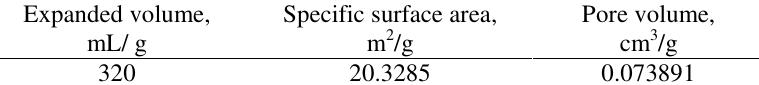
Table 1. Structural parameter of EG loaded with titania * Expanded volume,